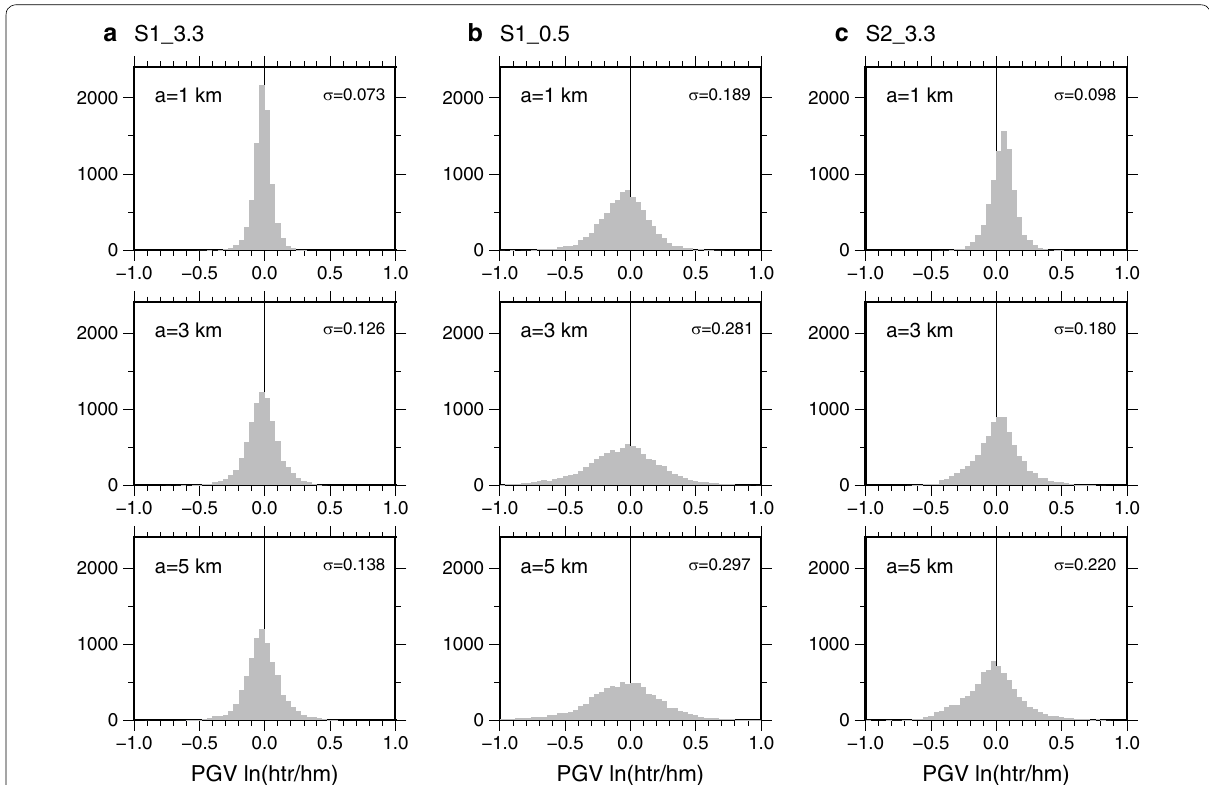
Fig. 7 Distribution of natural logarithm of heterogeneous-to-homogeneous PGV ratio. Correlation lengths of 1, 3, and 5 km for source models a S1_3.3, b S1_0.5, and c S2_3.3. Standard deviation is indicated on the right top of each